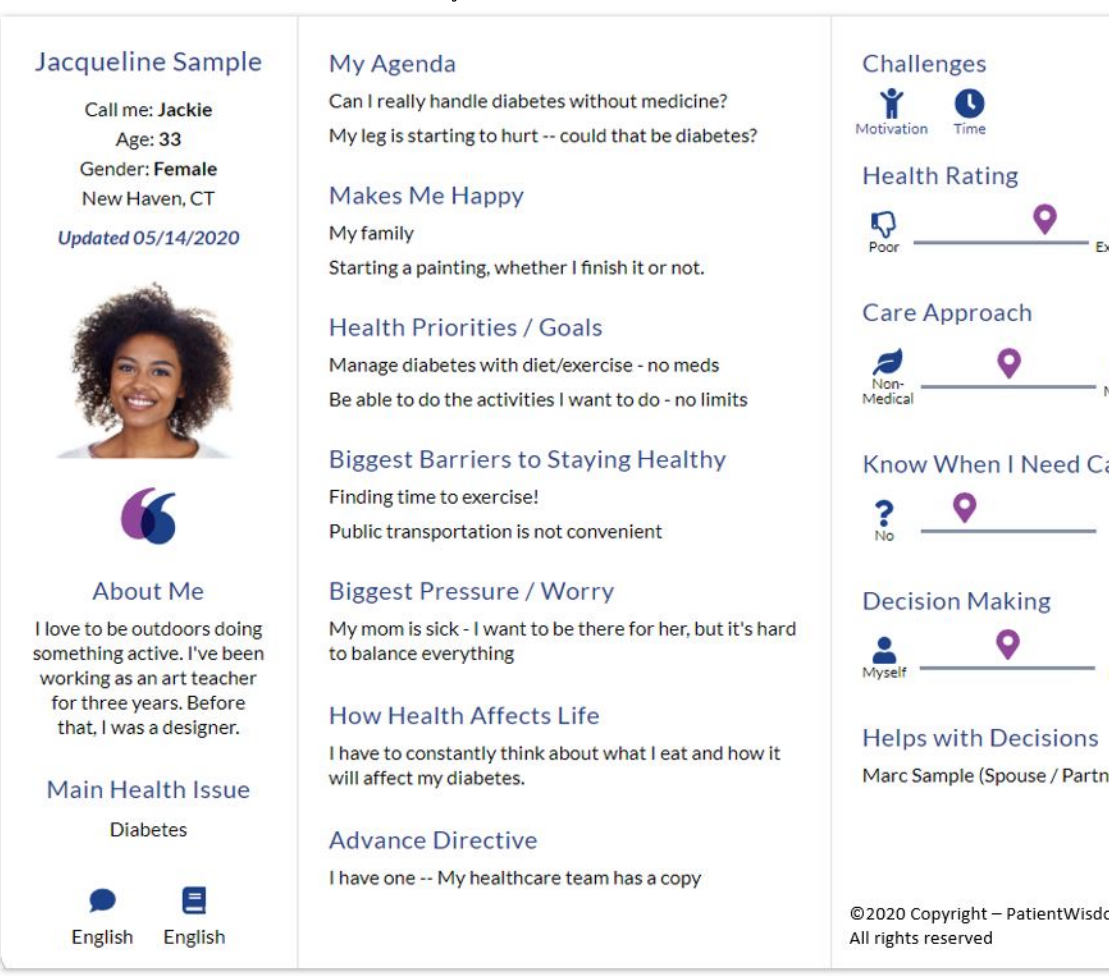
Figure 2. Patient contextual data tool one-screen